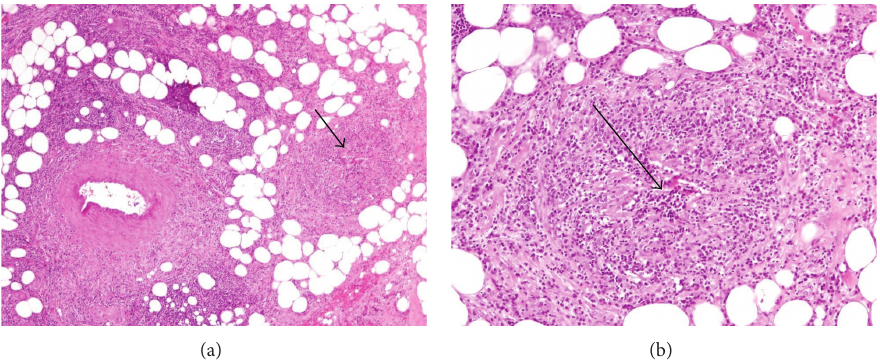
Figure 1: (a) Adipose tissue with heterogeneous intense inflammatory infiltrate consisting of lymphocytes and plasma cells polytypic. The inflammatory infiltrate around the artery but infiltrates vein walls (arrow). H-E original magnification × 40. (b) Higher magnification, a vein totally occluded (arrow). H-E original magnification ×